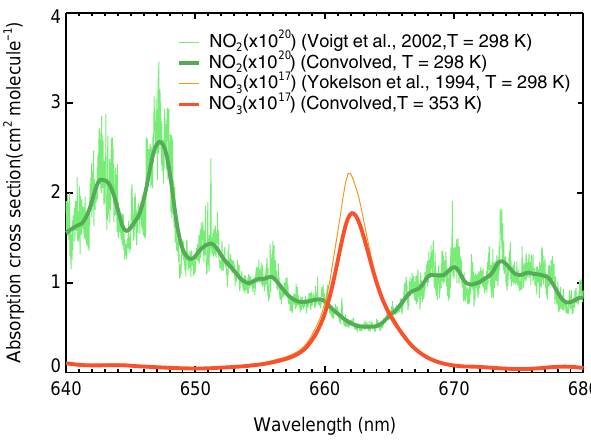
Figure 3. Absorption cross section of NO 3 and NO 2 from 640 to 680nm. The green thin line is the original cross section of NO 2 at 298K determined by Voigt et al. (2002), the green thick line is the convolved result, the orange thin line is the original cross section of NO 3 at 298K determined by Yokelson et al. (1994), and the red thick line is the temperature-scaled and convolved cross section at 353K.